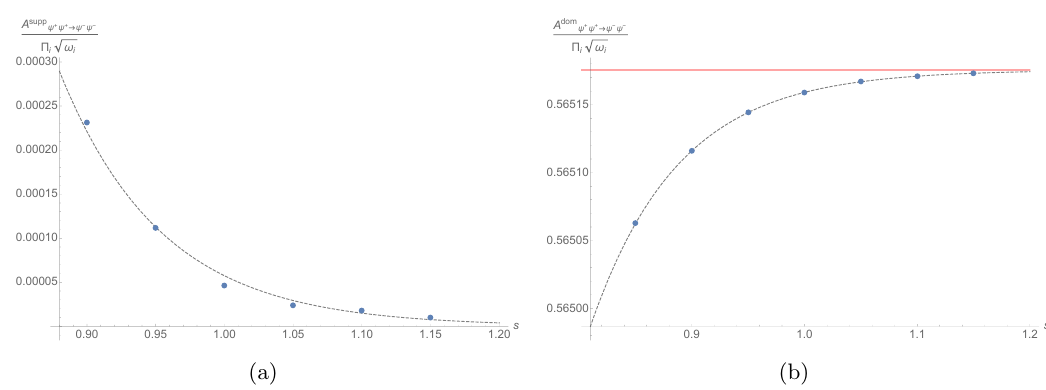
Figure 9 . Contributions to the open string scattering amplitudes on FZZT brane from (a) the diagrams in (cid:12)gures 8a,c and two other diagrams that are exponentially suppressed in the long string limit, and (b) the diagram in (cid:12)gure 8b and another diagram that converge to A L + L ! L + L exponentially in the long string limit, evaluated numerically as a function of s , at (cid:12)xed renormalized long string energies (cid:15) 1 = 0 : 2 ; (cid:15) 2 = 0 : 4 ; (cid:15) 3 = 0 : 35. In comparison to (3.11), we have included a factor p of 1 = (cid:5) 4 ! i due to the normalization of the long string asymptotic state. Exponential (cid:12)ts are i =1 shown as dashed gray curve, whereas the long string limit amplitude is marked in